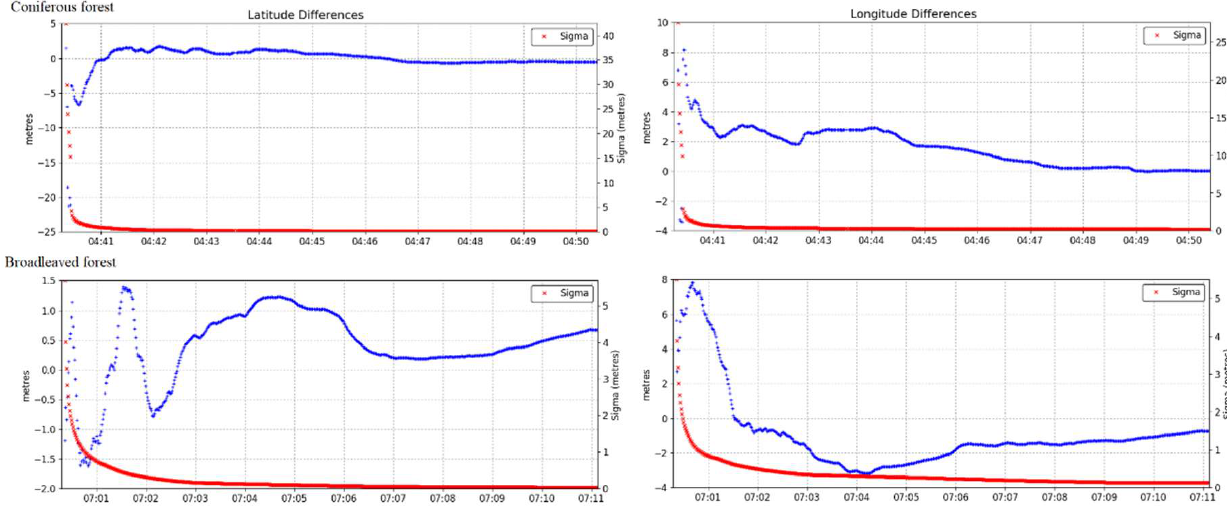
Figure 6. Variation in the positioning accuracy of the Galaxy 6 GNSS for a coniferous forest and a broadleaved forest over time.